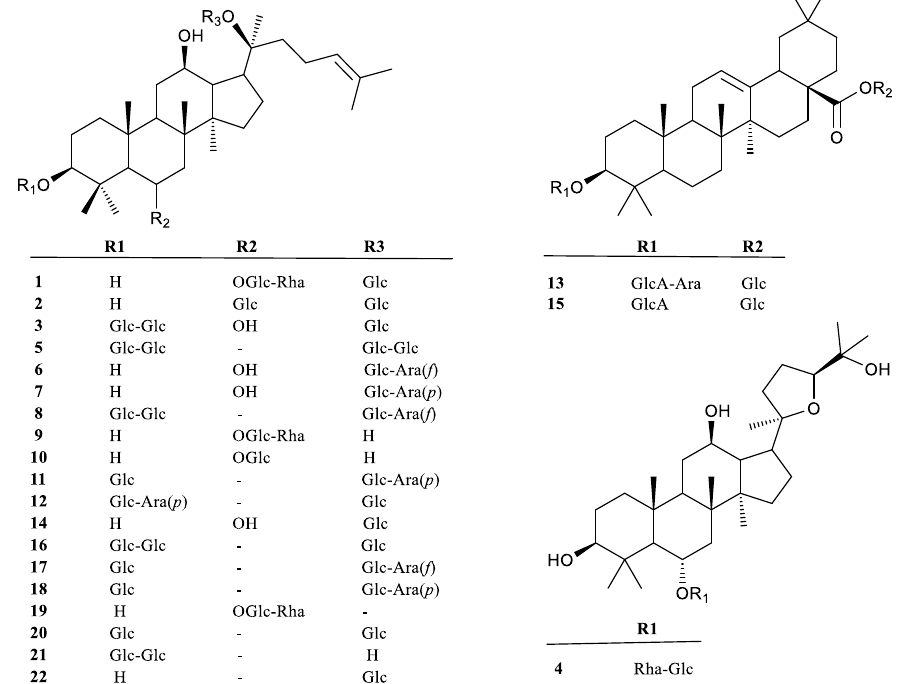
Figure 1. Chemical structures of the 22 investigated saponins in P. quinquefolium cultivated in the Heilongjiang province.